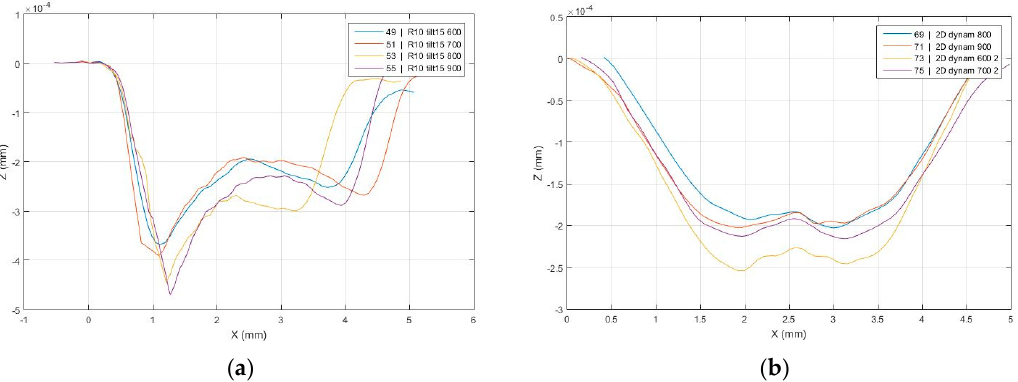
Figure 6. VEH R1O tool—tilting 15 ◦ in the + Y axis ( a ); symmetrization by sequential tilting 15 ◦ in the + X, + Y, − X, and − Y axes in the dynamic mode ( b ).